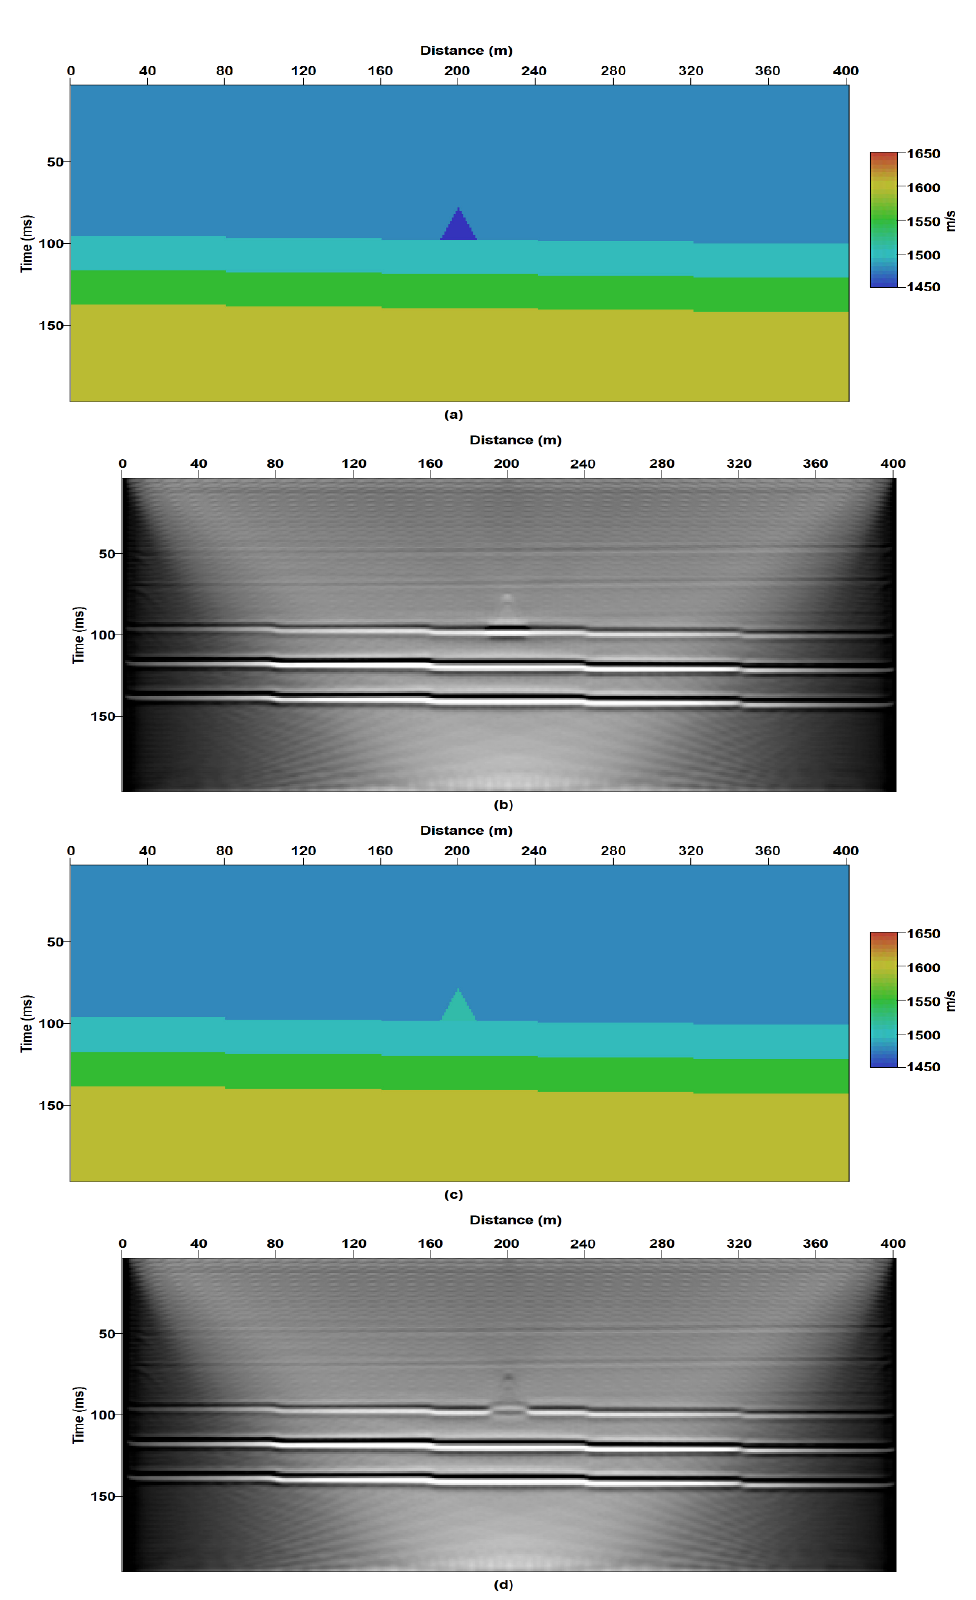
Figure 6. Numerical imaging results: ( a ) input velocity model of the negative acoustic variant with the flat model; ( b ) RTM image of ( a ); ( c ) input velocity model of the positive acoustic variant with the flat model; ( d ) RTM image of ( c